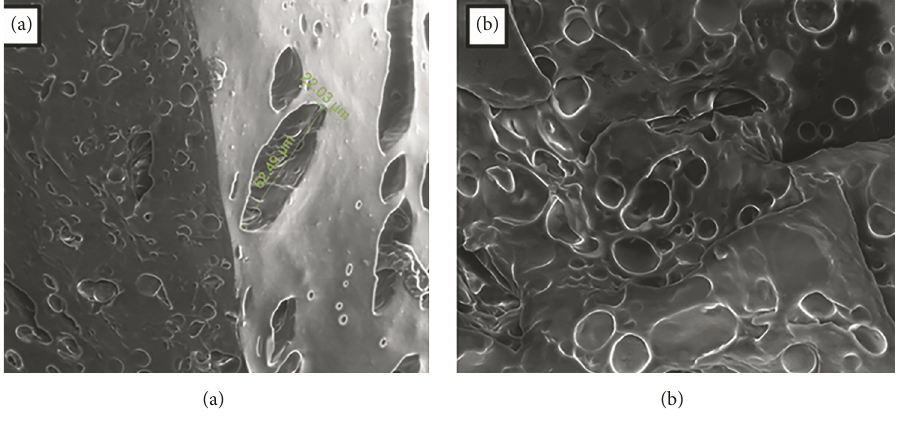
Figure 9: SEM micrographs of the hydrogel PG-(CA,